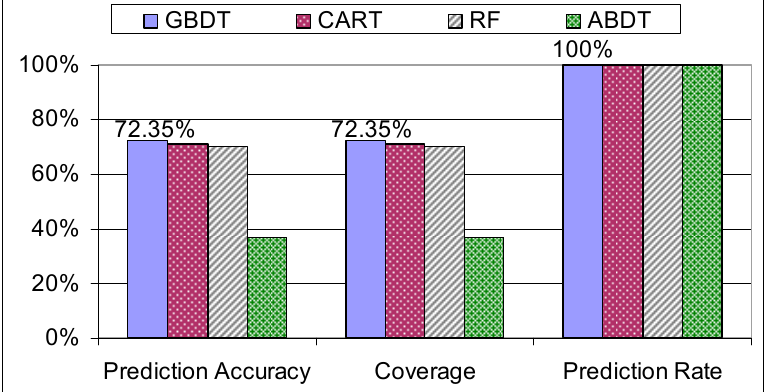
Figure 11. Evaluation of decision trees on the “Trainees” dataset.